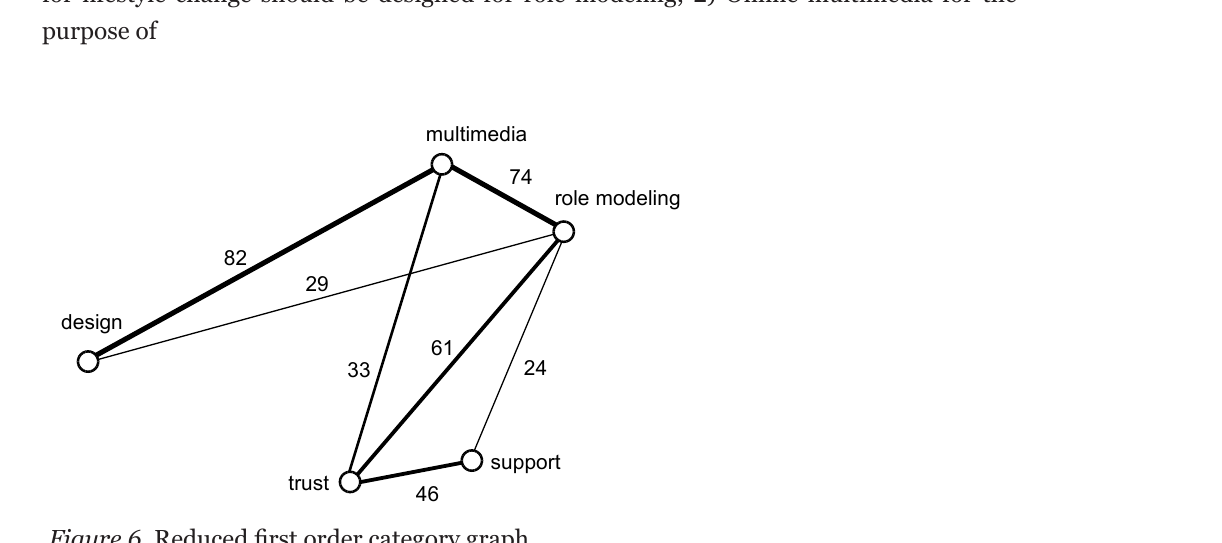
Figure 6 . Reduced first order category graph role modelling should promote a sense of safety and security, avoid risk of physical or emo- tional harm, and ensure that only accurate up-to-date information is provided; 3): Social support for lifestyle change should involve trusted role models.